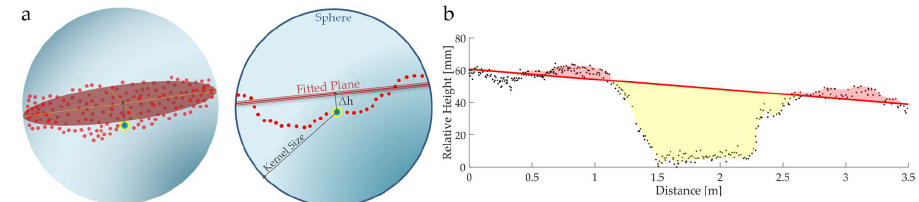
Figure 6. Roughness evaluation. ( a ) Overview in axonometry and profile of the search sphere, with the points belonging to it, the fitted plane and the ∆ h . ( b ) Profile view of the fitted plane and point cloud. The area colored in yellow indicates a pothole, the areas in light red two swells/shoves.